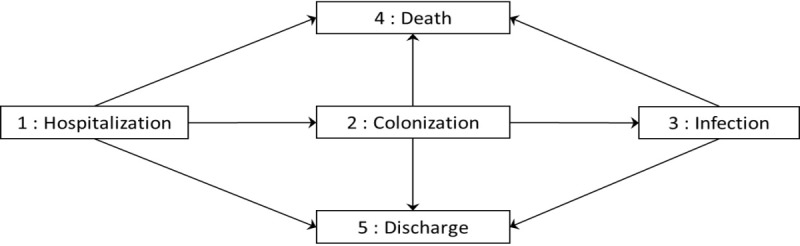
Multistate model representation.